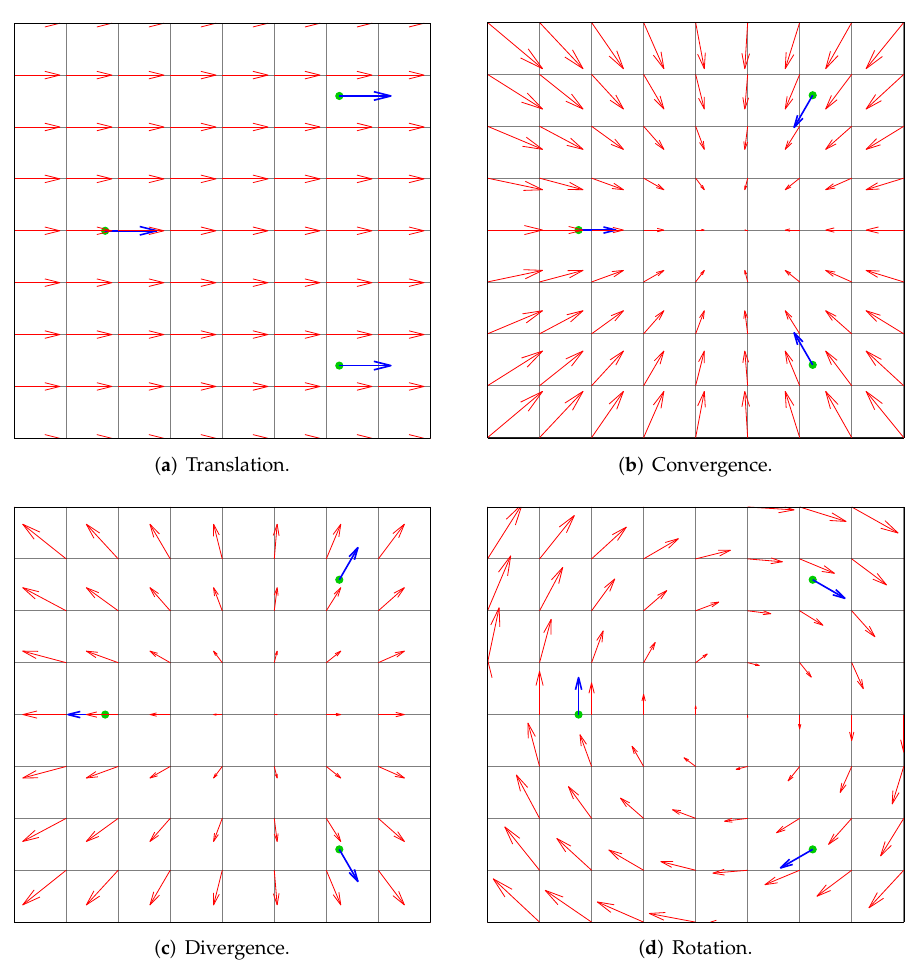
Figure 5. Vector field computed for the 4 toy examples. The red arrows represent the vector field of the associated linear dynamical system